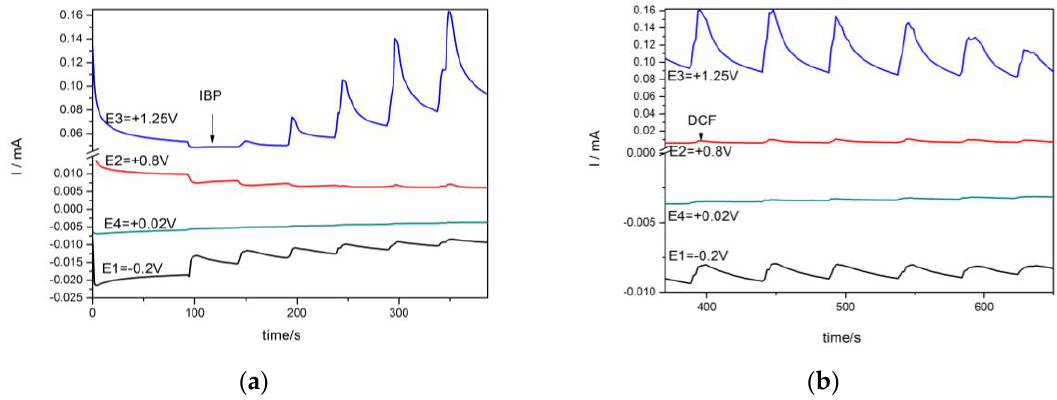
Figure 4. CA recorded under two potential levels of +0.8 V and +1.25 V vs. SCE at the HKUST-CNF electrode in 0.1 M Na 2 SO 4 supporting electrolyte (curve 1) and in the presence of ( a ) 2 mg·L −1 IBP (curve 2), 4 mg·L −1 IBP (curve 3), 6 mg·L −1 IBP (curve 4), 8 mg·L −1 IBP (curve 5), 10 mg·L −1 IBP (curve 6); ( b ) 2 mg·L −1 DCF (curve 2), 4 mg·L −1 DCF (curve 3), 6 mg·L −1 DCF (curve 4), 8 mg·L −1 DCF (curve 5), 10 mg·L −1 DCF (curve 6).